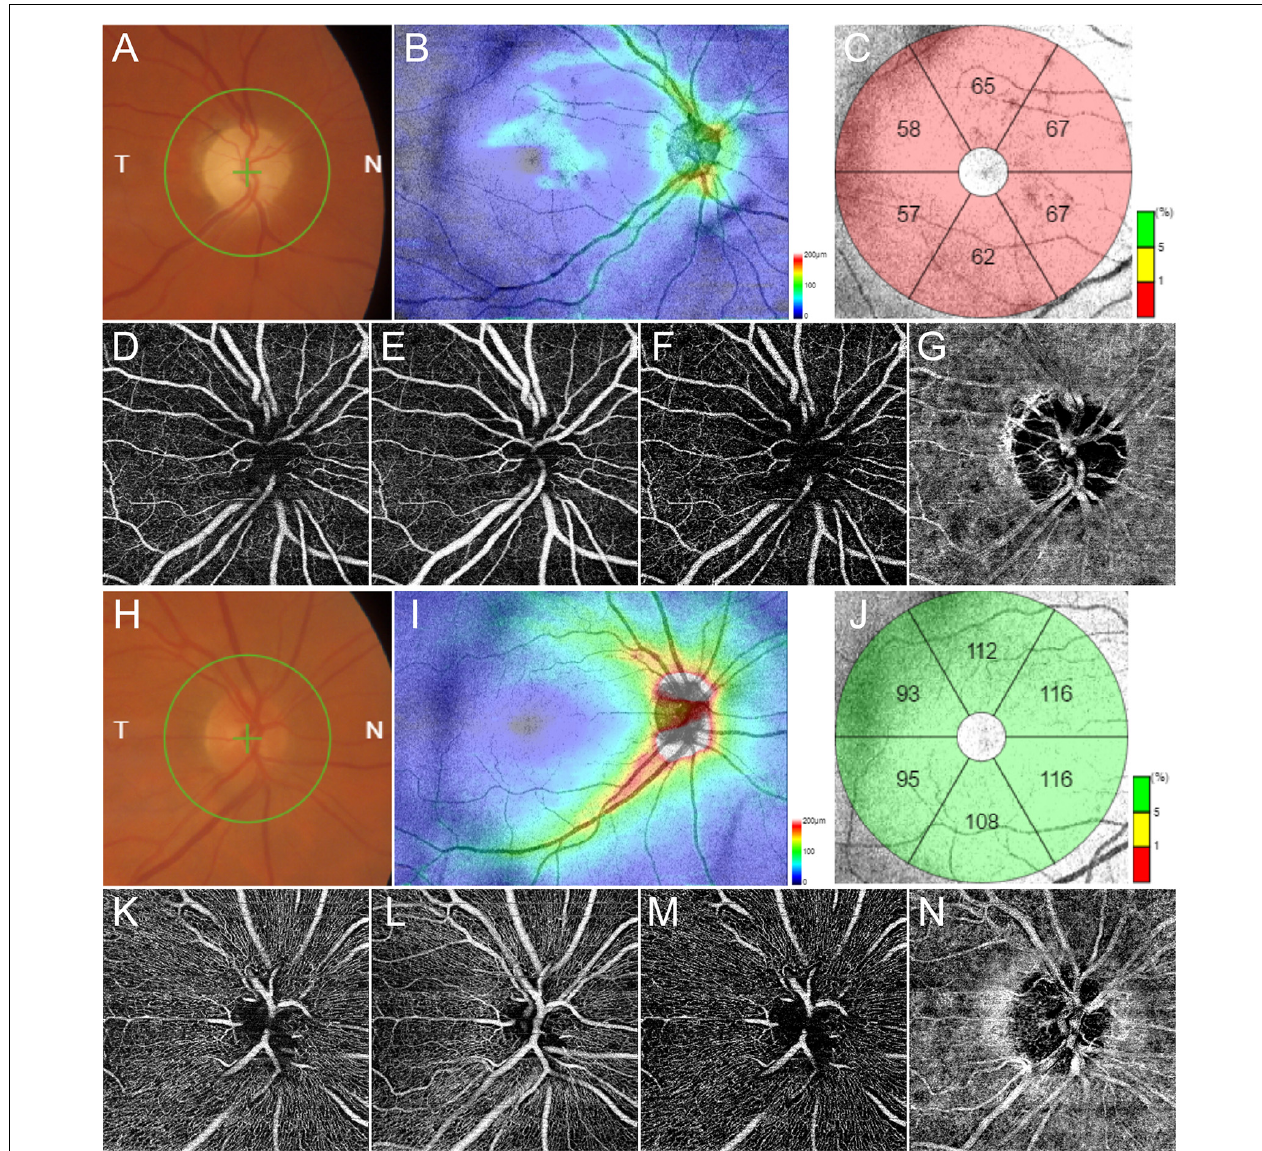
FIGURE 1 | Multimodal imaging in glaucoma. Fundus examination reveals an evident excavation of the optic disc (A) . Structural optical coherence tomography (OCT) detects a remarkable thinning of retinal nerve fibers layer (RNFL) (B) and ganglion cells layer (GCL) (C) . OCT angiography (OCTA) shows rarefied radial peripapillary capillary and deep capillary plexa ( D,F respectively), and preserved superficial capillary plexus and choriocapillaris ( E,G respectively). Multimodal imaging findings in a normal control is shown in (H–N) , respectively.